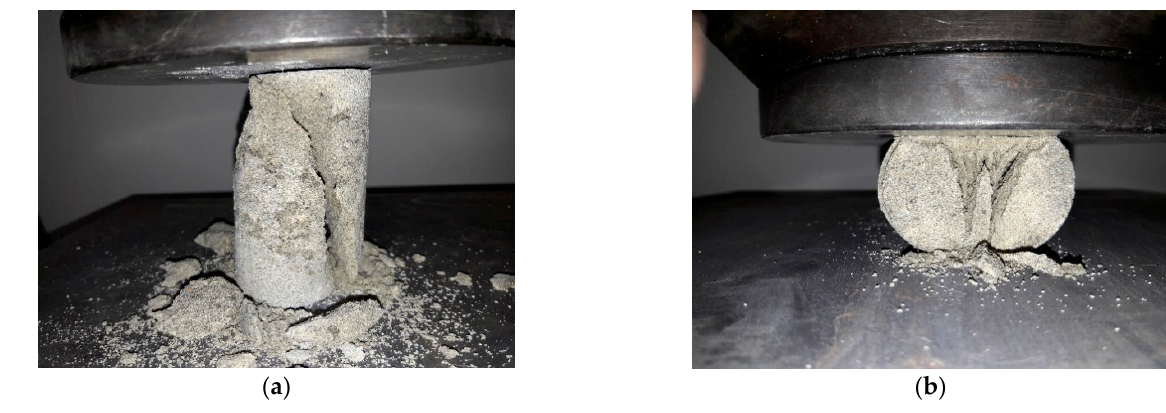
Figure 6. Strength test: ( a ) compressive; ( b ) indirect tensile.